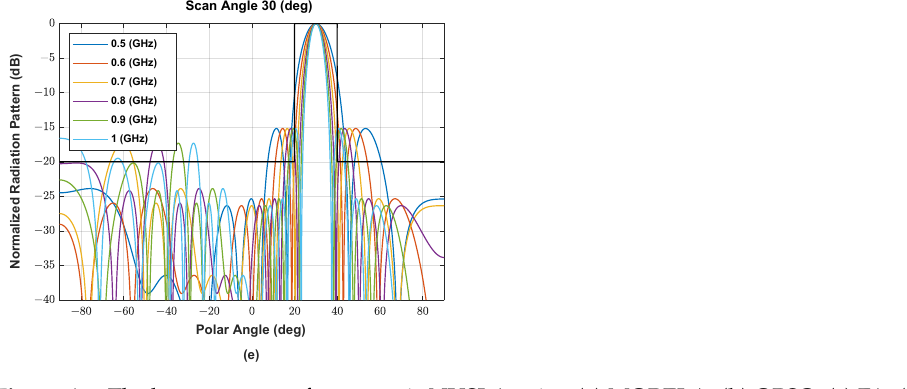
Figure A2. The beam pattern of symmetric NUSLA using ( a ) MORELA, ( b ) QPSO, ( c ) FA, ( d ) SSA, and ( e ) MALO in case for θ 0 = 30°.